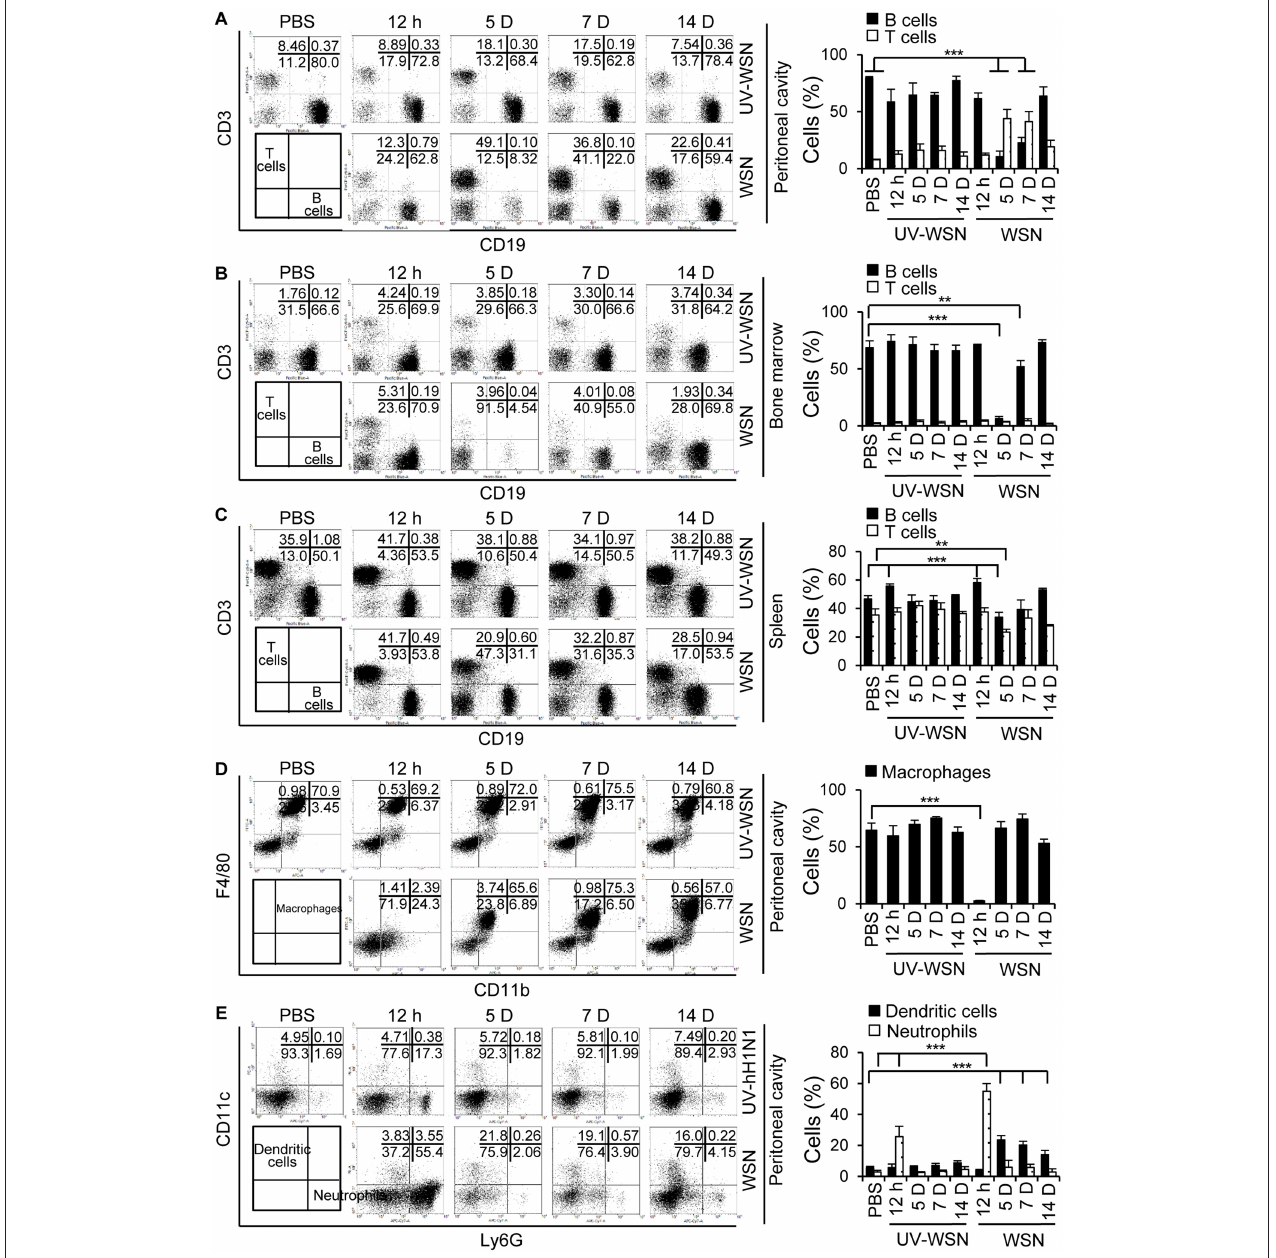
FIGURE 2 | Analysis of cell populations following intraperitoneal challenge with A/WSN/1933 virus or UV-inactivated A/WSN/1933 virus. BALB/c mice ( n = 5/group) were sacrificed at 12h, 5, 7, and 14 days after intraperitoneal challenge with 5 × 10 6 pfu of A/WSN/1933 virus (WSN) or UV-inactivated A/WSN/1933 virus (UV-WSN). Peritoneal cells, bone marrow cells and splenocytes were harvested, counted, and stained with fluorescence-conjugated antibodies and analyzed by flow cytometry. Cells from control mice at 14 days after intraperitoneal injection of PBS were used as an uninfected control. (A-C) FSC low SSC low cells of peritoneal cells, bone marrow cells, splenocytes were gated, and lymphocyte populations of the peritoneal cavity (A) , bone marrow (B) , and spleen (C) were sorted into CD3 and CD19 subsets. (D,E) Peritoneal cells (FSC low SSC high ) were gated, and two populations, F4/80 high CD11b high (macrophages) and F4/80 low CD11b low (non-macrophages) were analyzed. (D) Peritoneal macrophages (F4/80 high CD11b high ) were sorted for F4/80 and CD11b double-positive phenotype. (E) The dendritic cell and neutrophil populations of the peritoneal cavity were sorted from F4/80 low CD11b low population using CD11c and Ly6G markers. Right panel showed the indicated cell population (%) among FSC low SSC low cells (A-C) and FSC low SSC high cells (D,E) . Each figure is representative of three independent experiments. ** p < 0.005, *** p < 0.0005.